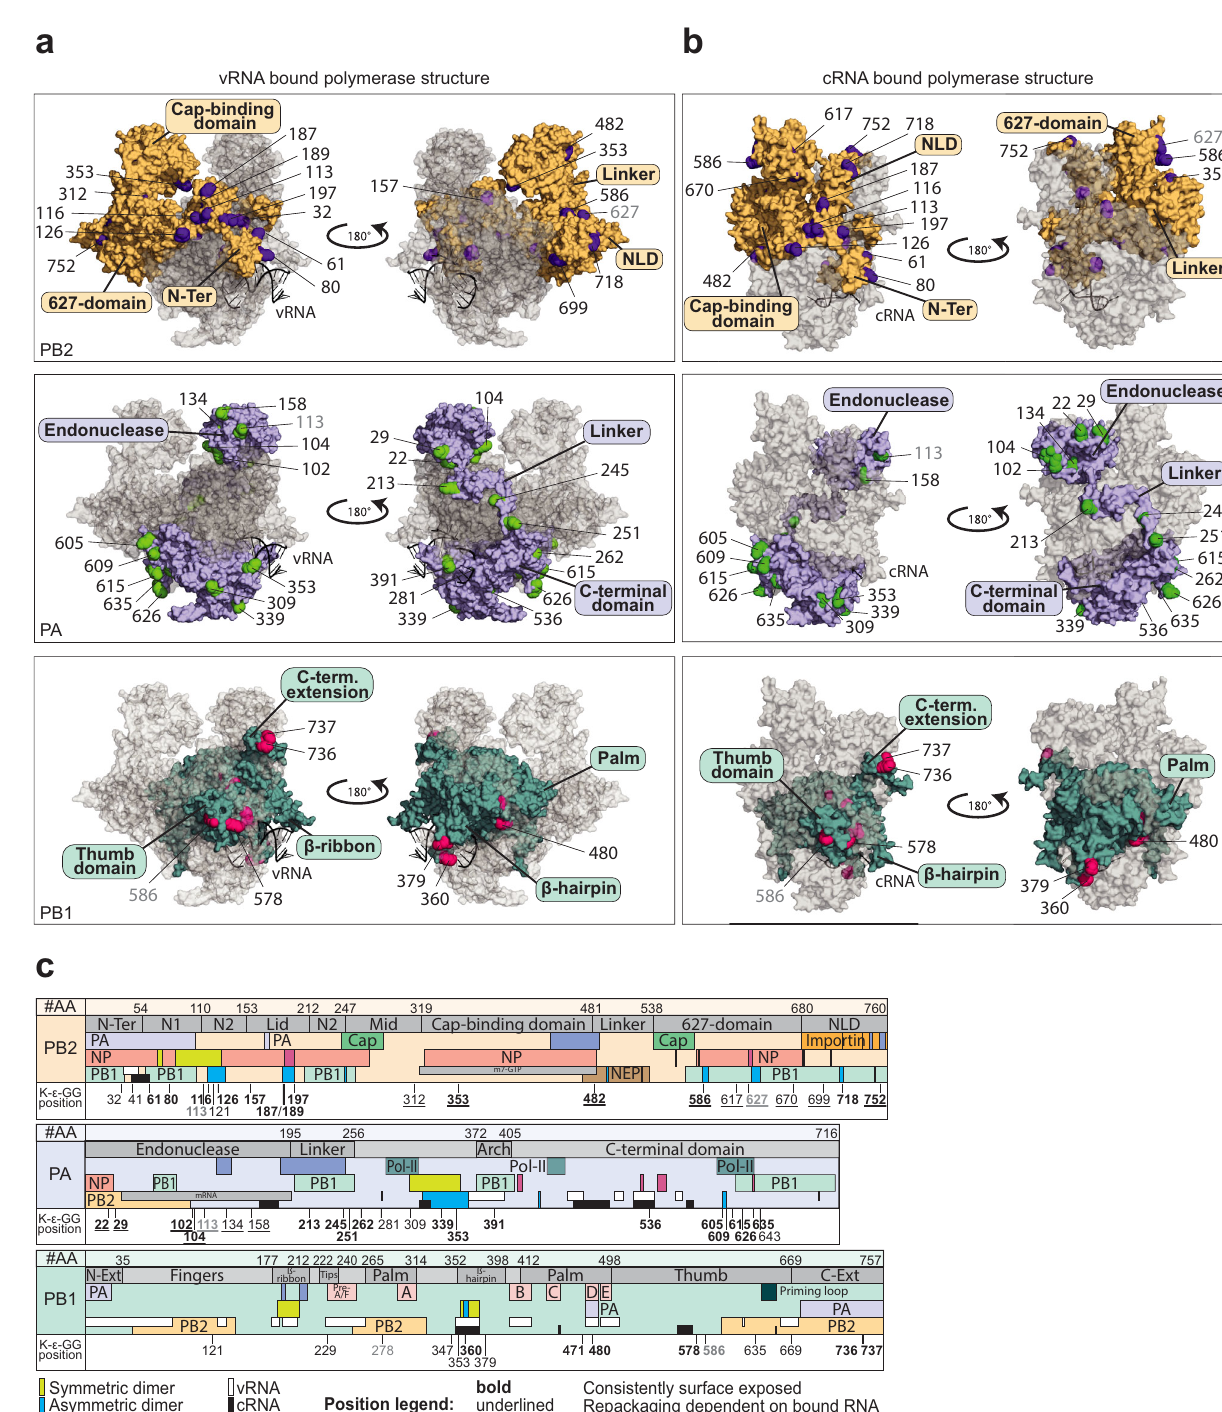
Fig.2|UB-modi fi edlysinesresideinfunctionaldomainsoftheIAVpolymerase. a , b 3D structuralmodelsofa WSN-adapted heterotrimeric IAVpolymerase bound tovRNA(adaptedfromPDB:4WSB; a) orcRNA(adaptedfromPDB:5EPI; b) created bycomparativehomologymodeling.Positionsoflysineswithdiglycylremnantsare depicted in violet (PB2, yellow, upper panel), green (PA, violet, middle panel), and magenta (PB1, turquoise, lower panel). c Linear models of PB2 (upper panel), PA (middle panel), and PB1 (lower panel) depicting the location of the identi fi ed di- glycylated lysines (K- ε -GG position) in previously described functional domains.